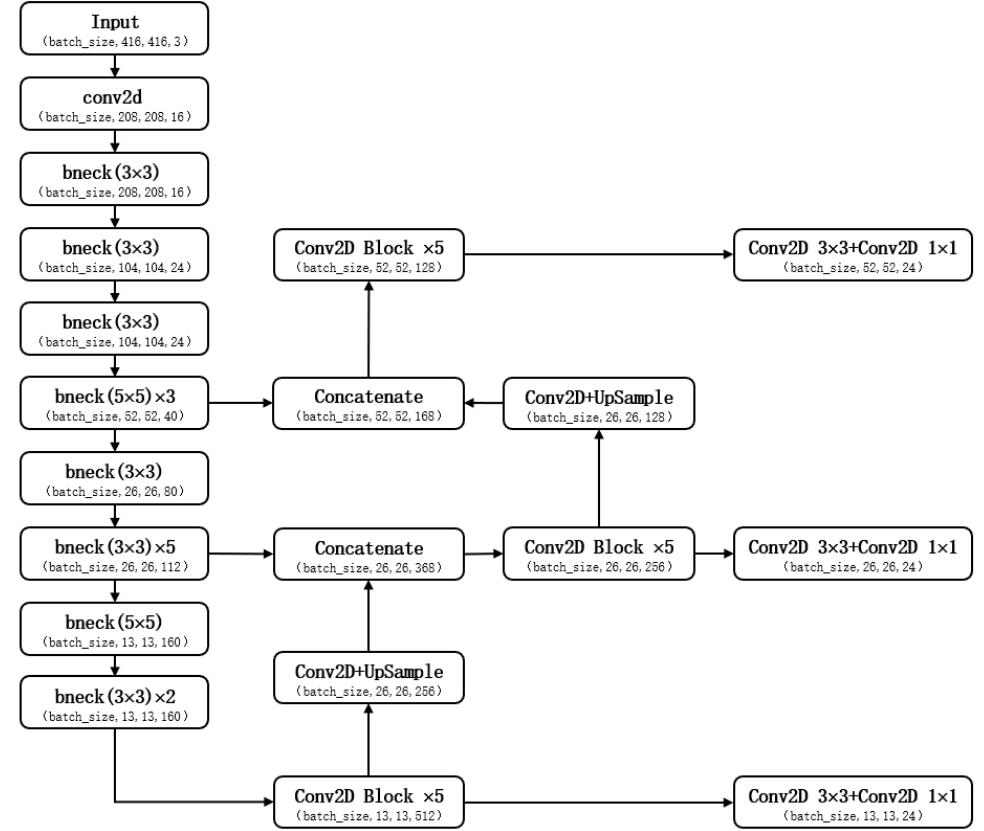
Figure 1. The structure of Tuna-YOLO. The improved MobileNet v3’s 6th, 12th, and 15th layer bneck structure were used as a branch to combine with the Neck part of YOLO v3.